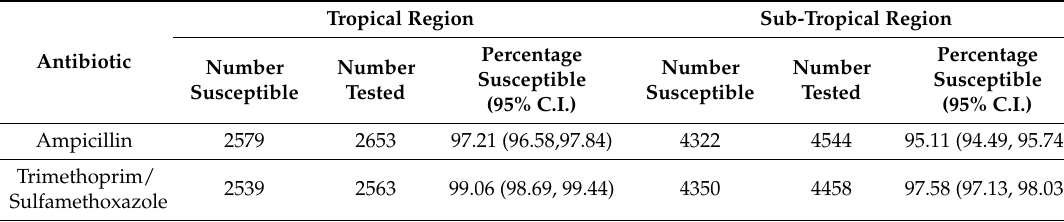
Table 1. susceptibility in tropical and sub-tropical regions for all positive specimens collected (both European Committee on Antimicrobial Susceptibility Testing (EUCAST) and The Clinical and Laboratory Standards Institute(CLSI) methods